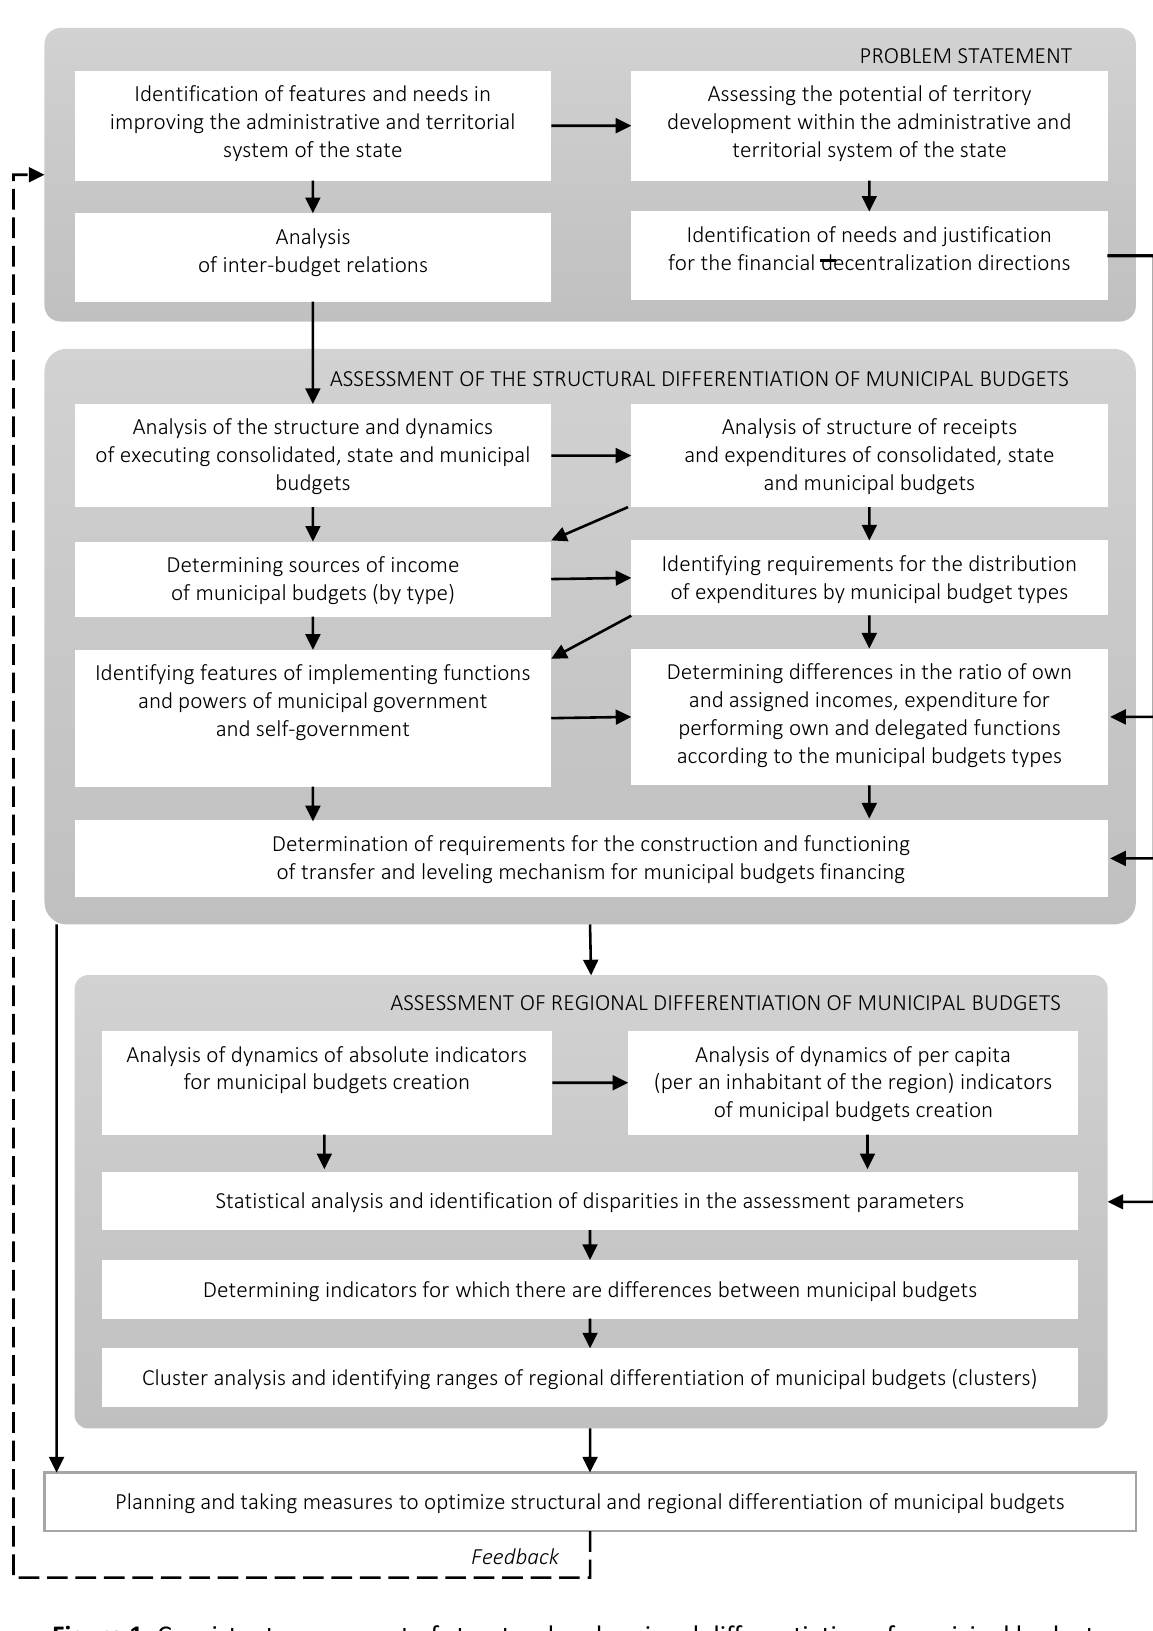
Figure 1. Consistent assessment of structural and regional differentiation of municipal